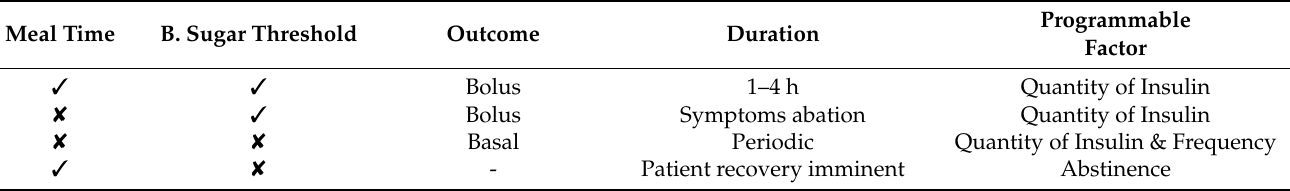
Table 1. Scenario of patient status &